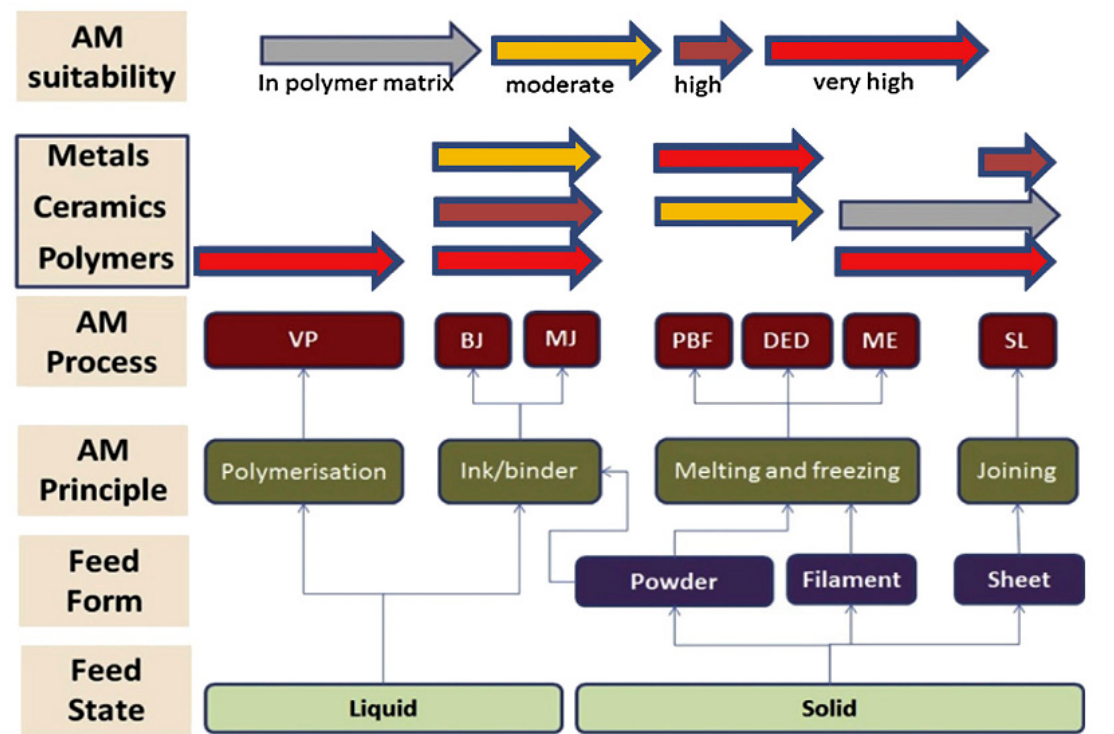
Figure 10. A schematic diagram of the relative suitability of additive manufacturing (AM) of three major types of materials (polymers, ceramics, and metals) in various feed forms and states using ASTM processes: Binder jetting (BJ); directed energy deposition (DED); material extrusion (ME); (4) material jetting (MJ); powder bed fusion (PBF); sheet lamination (SL); and vat photopolymerization (VP) [97].